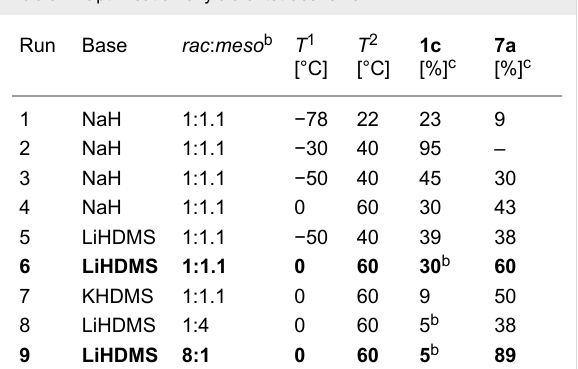
Table 1: Optimisation of yield of tetracene 7a .